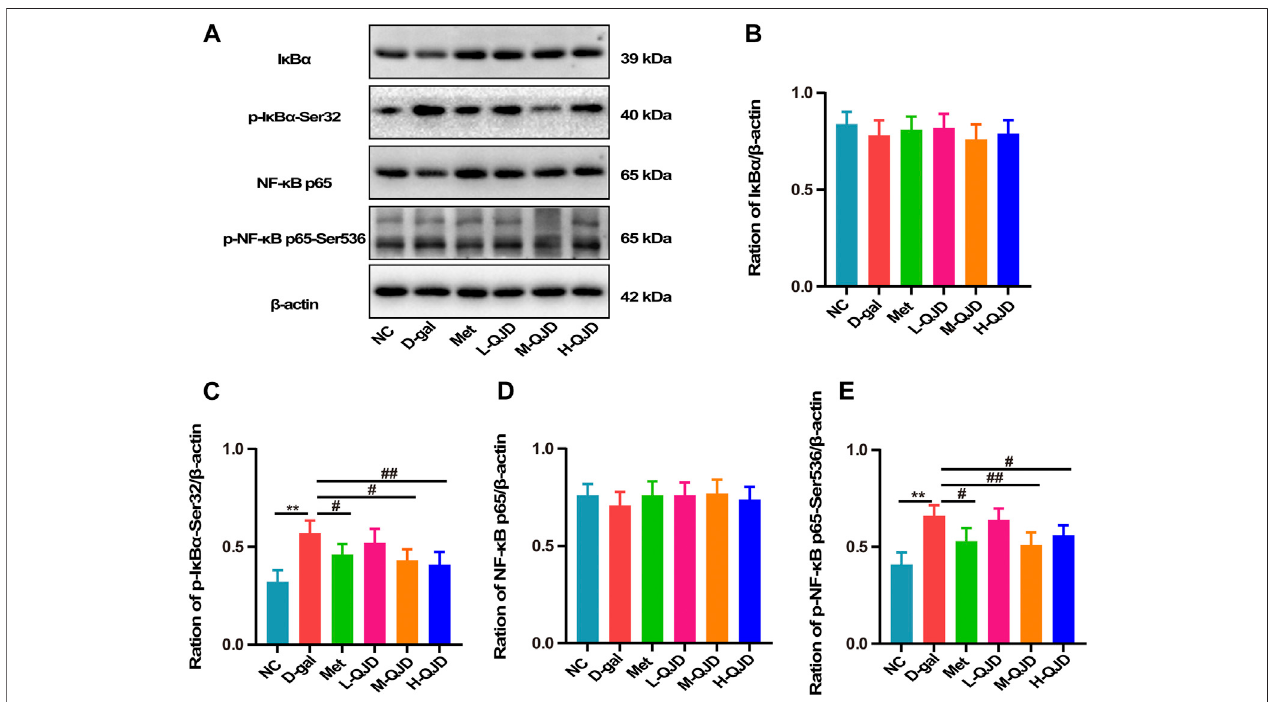
FIGURE 6 | QJD inhibited the NF- κ B signaling pathway in the hippocampus of D-gal – induced mice. (A) Representative Western blot bands showing the protein expression levels of I κ B α , p-I κ B α -Ser32, NF- κ B p65, and p-NF- κ B p65-Ser536 in the hippocampus. (B) Relative protein expression level of I κ B α . (C) Relative protein expression level of p -I κ B α -Ser32. (D) Relative protein expression level of NF- κ B p65. (E) Relative protein expression level of p-NF- κ B p65-Ser536. All data were presented as mean ± SEM ( n (cid:1) 6/group). ** p < 0.01 vs. NC group; # p < 0.05 and ## p < 0.01 vs. D-gal